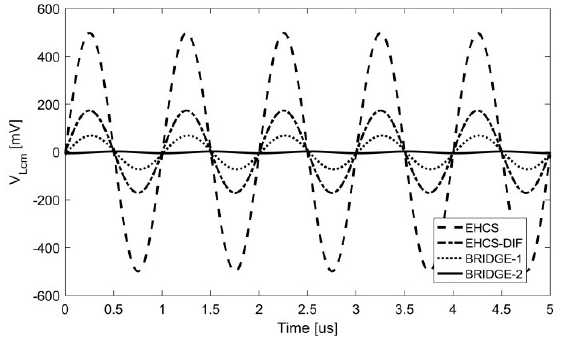
Fig.15: Simulated common mode load voltage ( V Lcm ) of the non- differential EHCS in time domain at 1 MHz for a load of 1